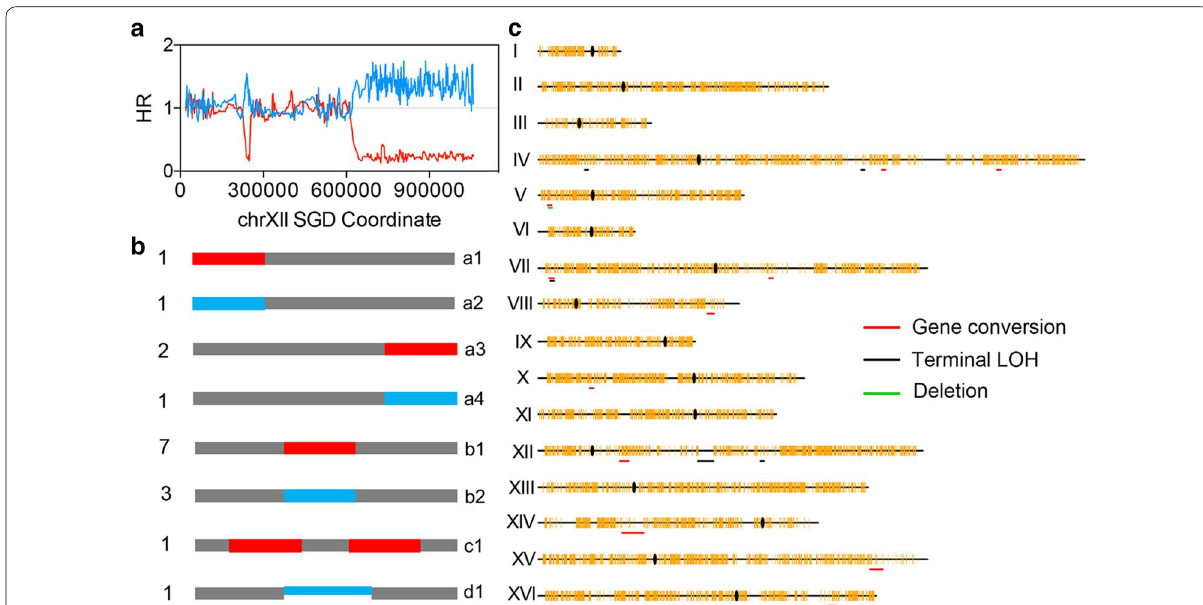
Fig. 3 Whole‑genome mapping of heat‑shock‑induced genomic alterations in the 21 JSC25‑1‑derived isolates treated with heat shock. a LOH events detected on chr X in the JSC25‑1‑derived isolate JP14. b Patterns of genetic events. The red and blue lines represent W303‑1A‑ and YJM789‑derived homologs, respectively. The gray lines indicate heterozygous regions. Classes a1–a4 represent terminal LOH events; b1, b2 and c1 represent gene conversion events; and d1 represents deletion event. c The genetic event distribution across the 16 chromosomes. The yellow vertical lines represent SNP